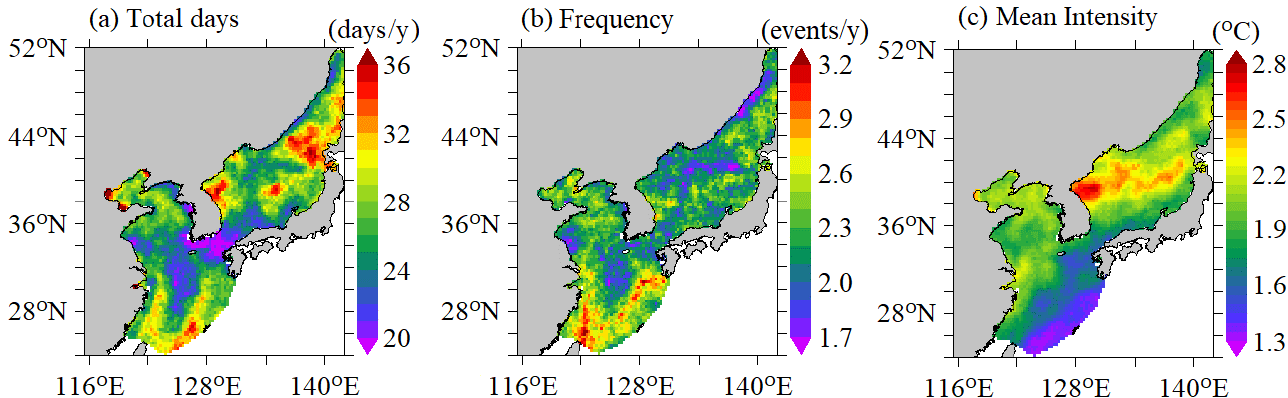
Figure 2. Spatial distribution of marine heatwave (MHW) characteristics averaged over 37 years (1982–2018) in the East Asian Marginal Seas. ( a ) Total days; ( b ) frequency; ( c ) mean intensity. The spatial mean intensity of MHWs was 1.9 ° C and ranged from 1.3 to 2.8 ° C during